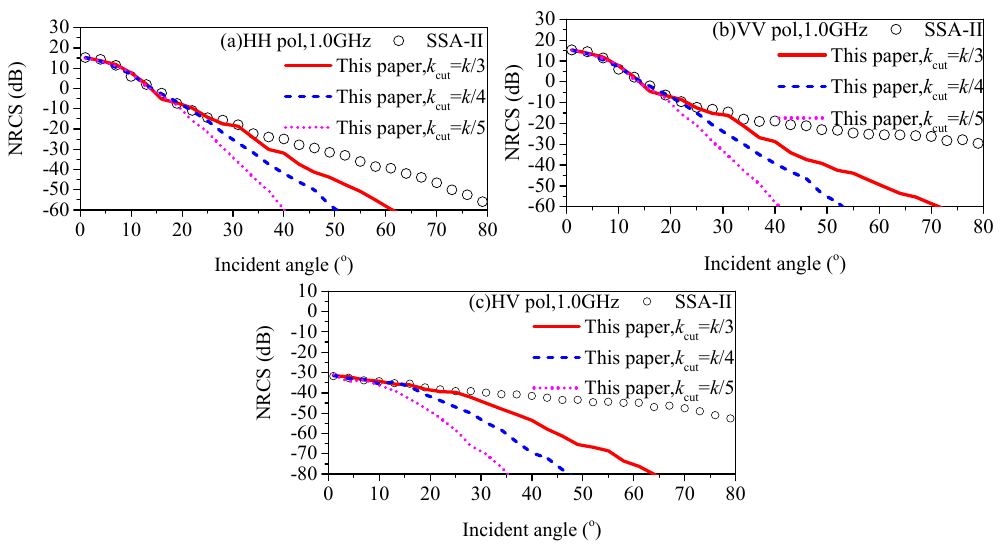
Figure 1. Comparison of normalized radar cross sections (NRCS) results between the proposed method and the original second order small slope approximation (SSA-II) method under monostatic configuration in near specular direction. ( a ) horizontal-transmit-horizontal-receive (HH) polarization; ( b ) vertical-transmit-vertical-receive (VV) polarization; ( c ) vertical-transmit-horizontal-receive (HV) polarization.